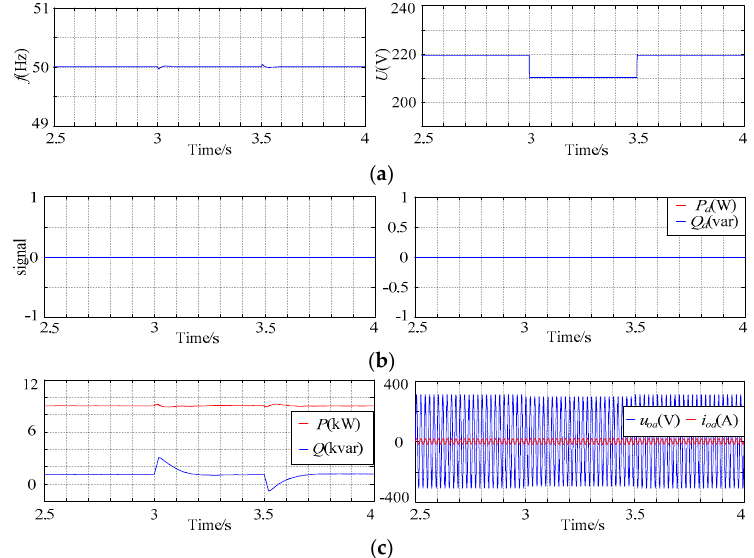
Figure 16. Islanding detection process in voltage disturbance of power grid: ( a ) The output voltage frequency and ampitude of the inverter; ( b ) The signal of islanding detection and the power disturbance; ( c ) The output power and the A phase voltage and current of inverter.